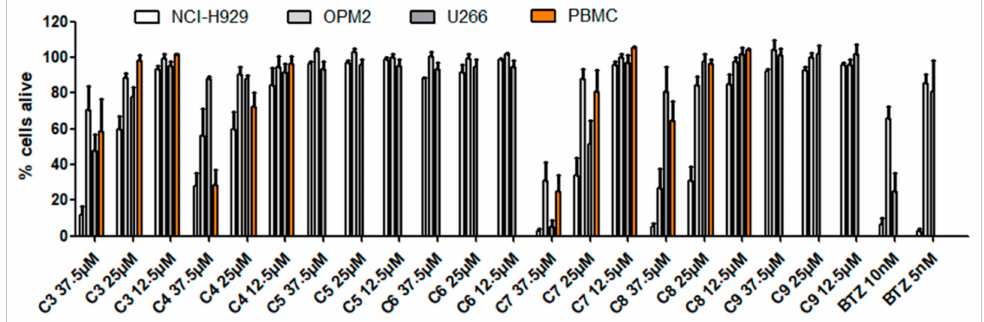
Figure5. ViabilityofMMcelllines(NCI-H929, OPM-2, U266)andhealthyperipheralbloodmononuclear cells (PBMC) 24 h after treatment with compounds 3 – 9 . Table 3. Cytotoxicity of compounds 3 – 9 and bortezomib (BTZ) after incubation for 24 h.